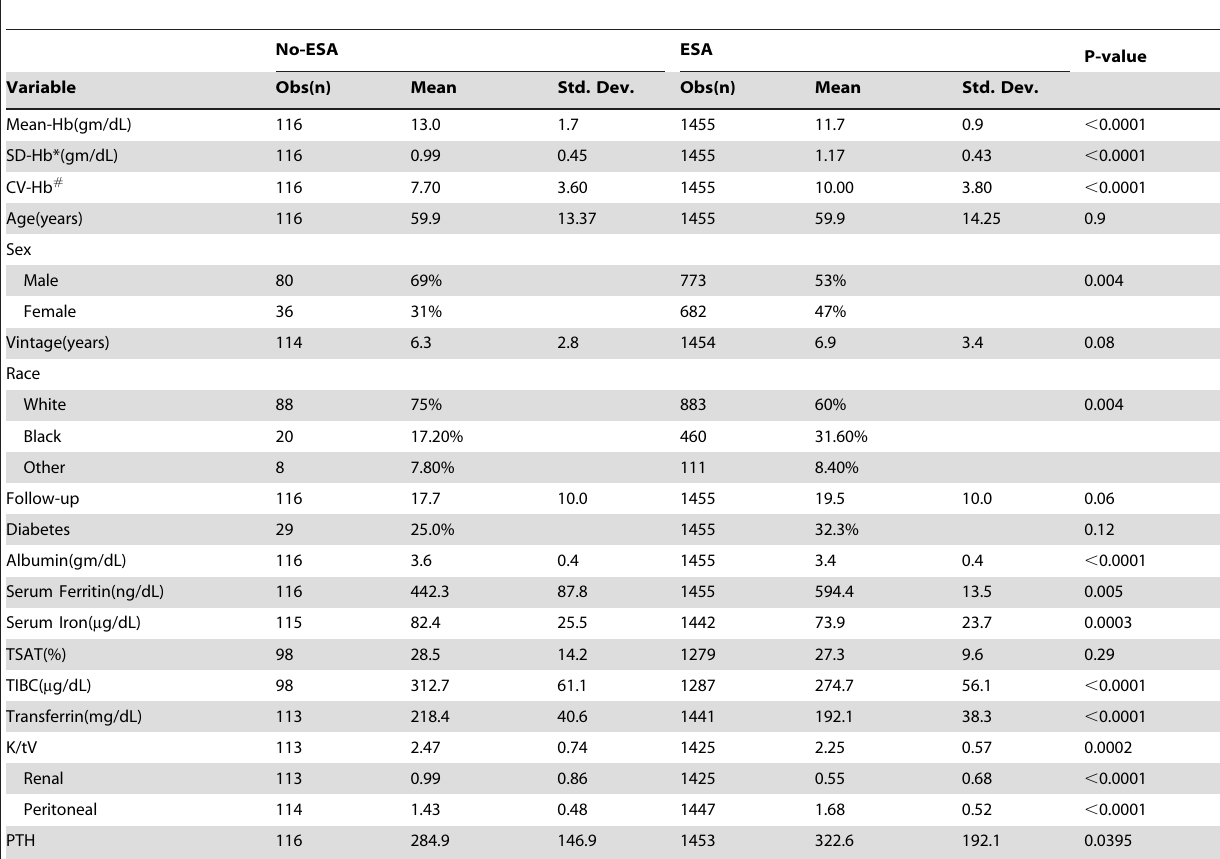
Table 1. Differences between ESA treated and ESA Naı¨ve PD